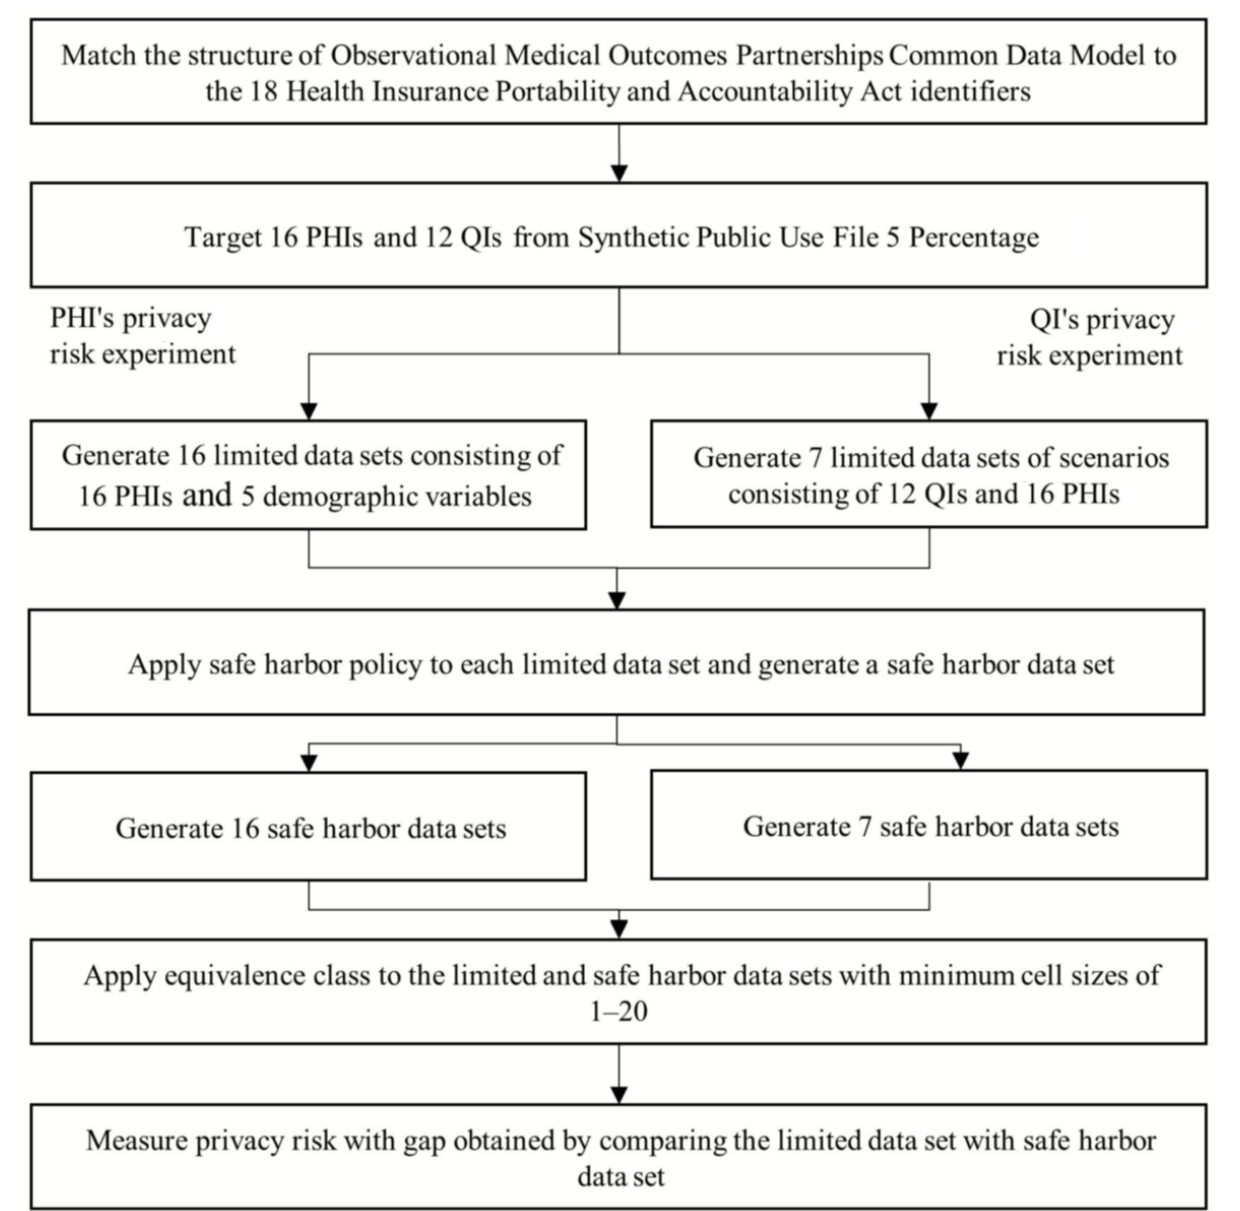
Figure 1. Study workflow. PHI: personal health identifier; QI: